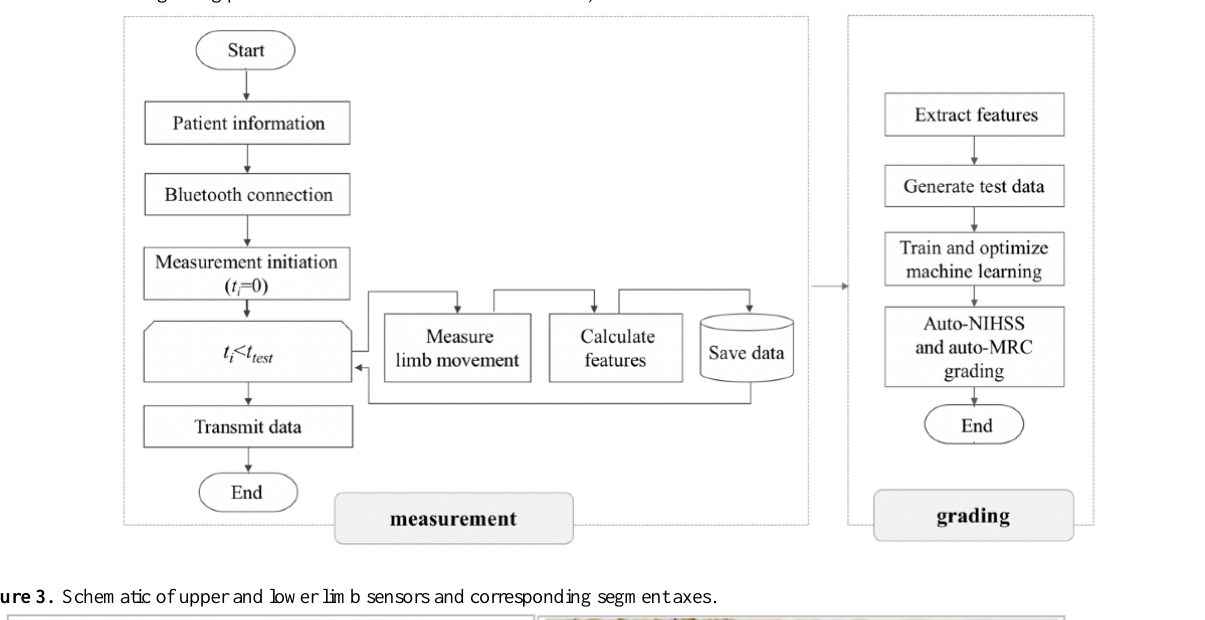
Figure 2. Automatic grading process. MRC: Medical Research Council; NIHSS: National Institutes of Health Stroke Scale.